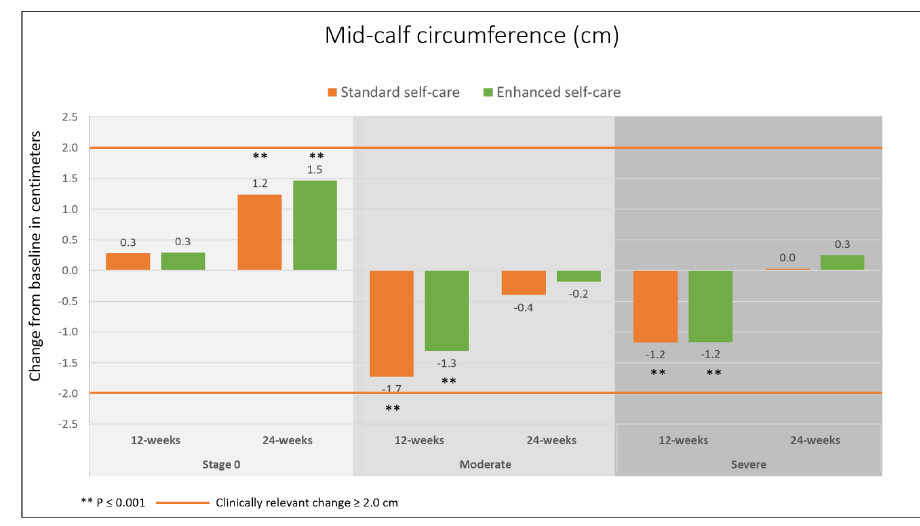
Figure 3. Change in mid-calf circumference from baseline by stage and group.